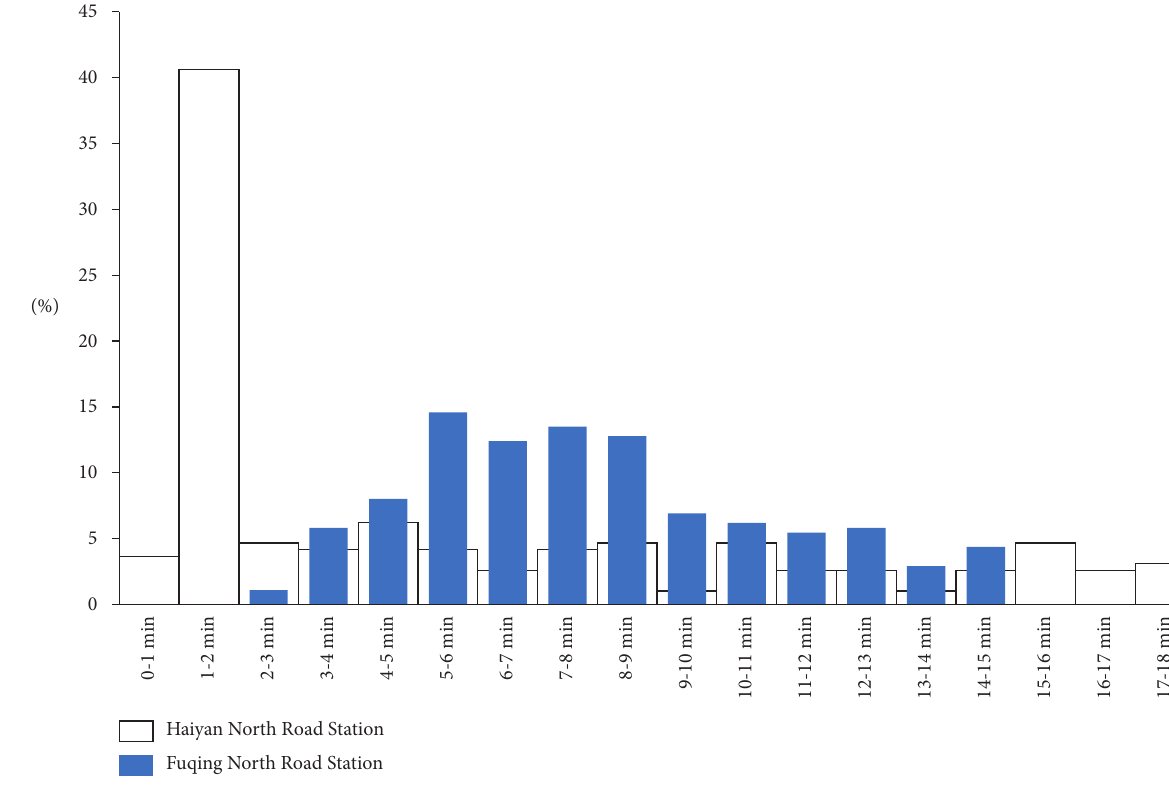
Figure 9: Histogram of data distribution of transfer